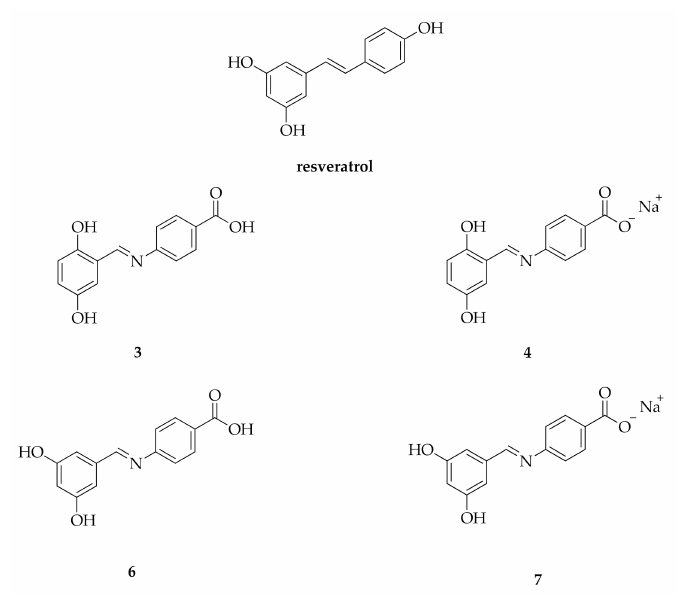
Figure 2. Structure of resveratrol and compounds 3 , 4 , 6 , and 7